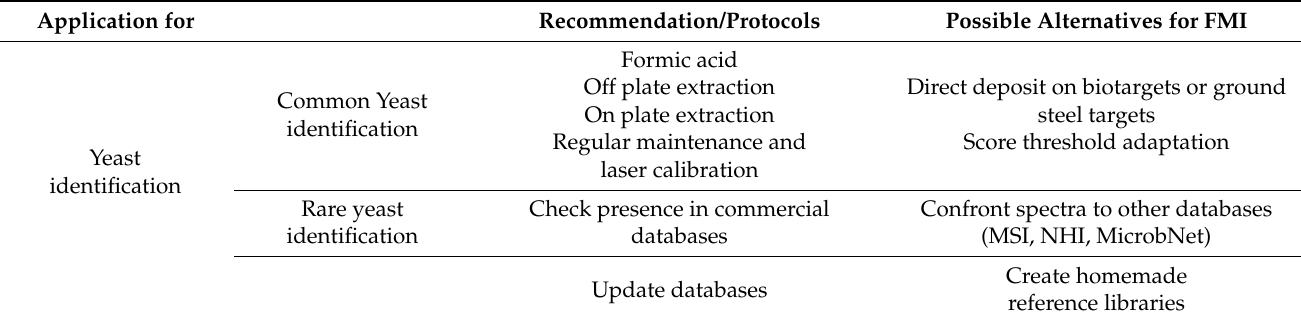
Table 1. Description of the different MALDI-TOF MS protocols existing in the field of medical mycology, and of their possible